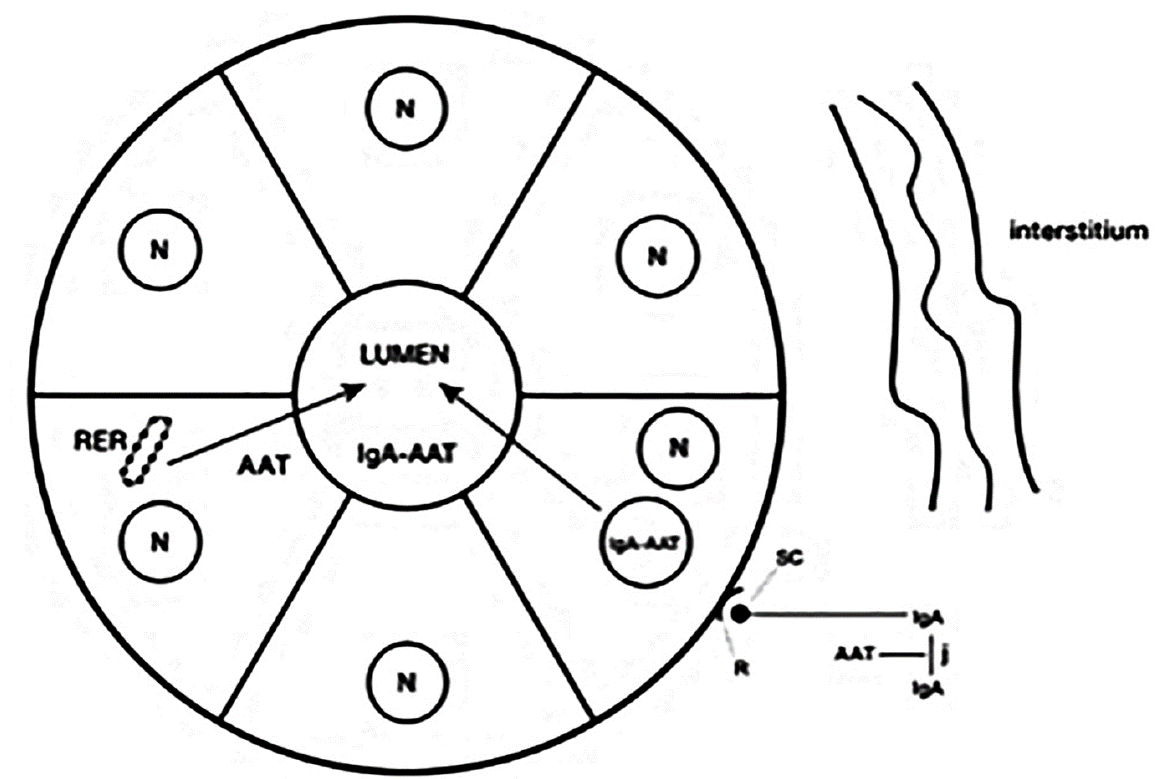
Figure 4. Schematic representation of transepithelial bypass of AAT bound to dimeric IgA from circulation or interstitium into the lumen of bile ducts. Mammary and salivary ducts follow the same mechanism for exporting AAT into milk and saliva. A small amount of AAT is synthesized in the RER of bile duct cells and directly secreted into the lumen.